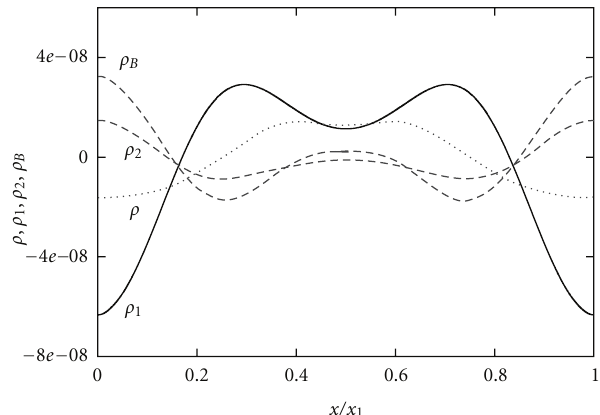
Figure 6: Di ff erent components of the charge distribution profile calculated by two-order parameter extended GL theory. The param- eter values are the same as in Figure